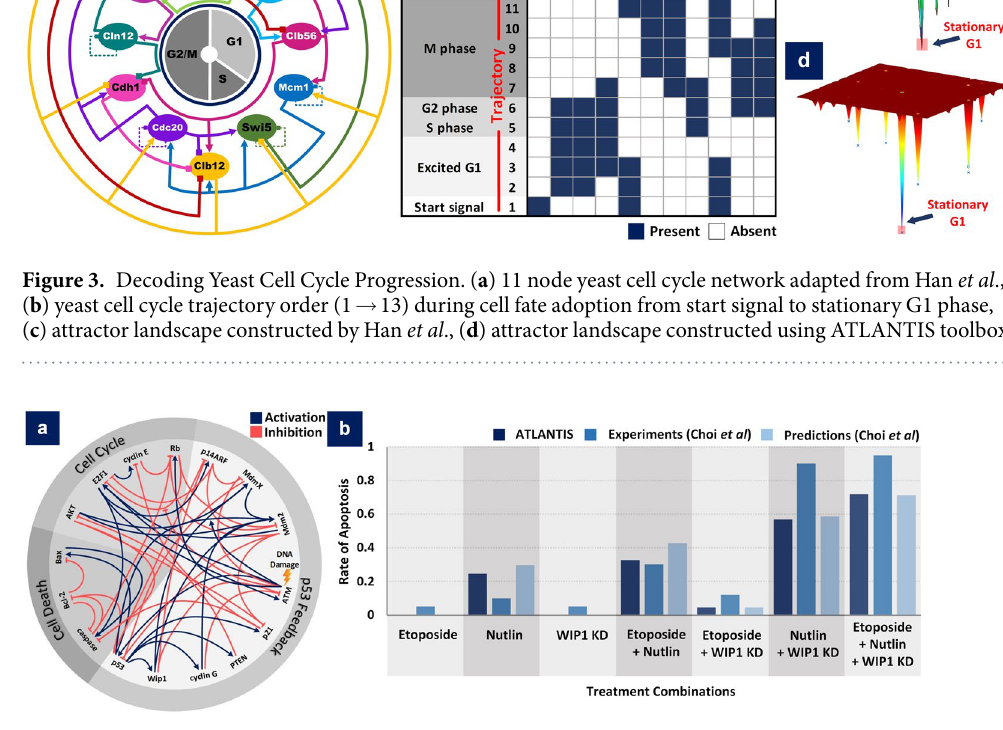
Figure 4. Evaluation of Combinatorial Therapeutic Efficacy to enhance P53-mediated Apoptosis in MCF-7 Breast Cancer Cell Lines. ( a ) P53 signaling network adapted from Choi et al . 19 . ( b ) Individual and combinatorial effects of Etoposide (E), Nutlin (N) and WIP1 knock-down (W) on P53-mediated apoptosis in MCF-7 cells from Choi et al . (experiments and predictions) and